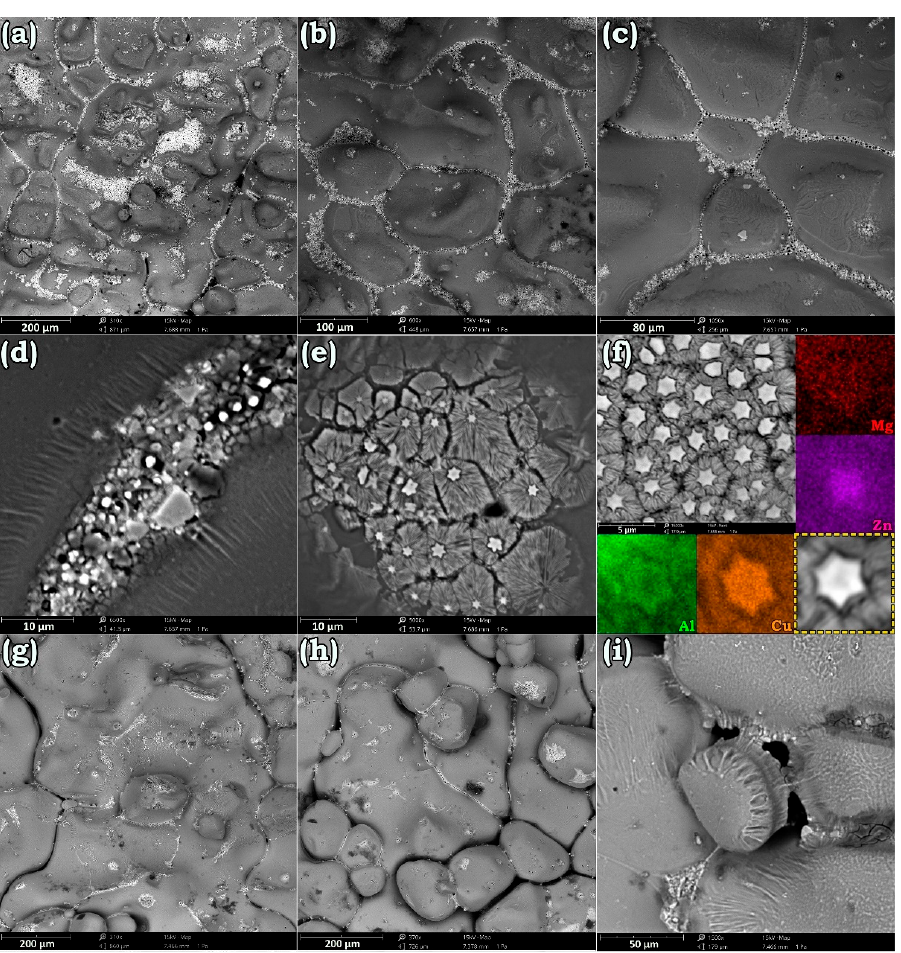
Figure 9. Illustration for the formation of the Cu-rich eutectic phases on the failure surface of the AA7475-AA2198 weld at AA7475 side after annealing at 560 °C ( a – f ) and 580 °C ( g – i ) for 1 h. AA7475-AA2198 weld at AA7475 side after annealing at 560 ◦ C ( a – f ) and 580 ◦ C ( g – i ) for 1